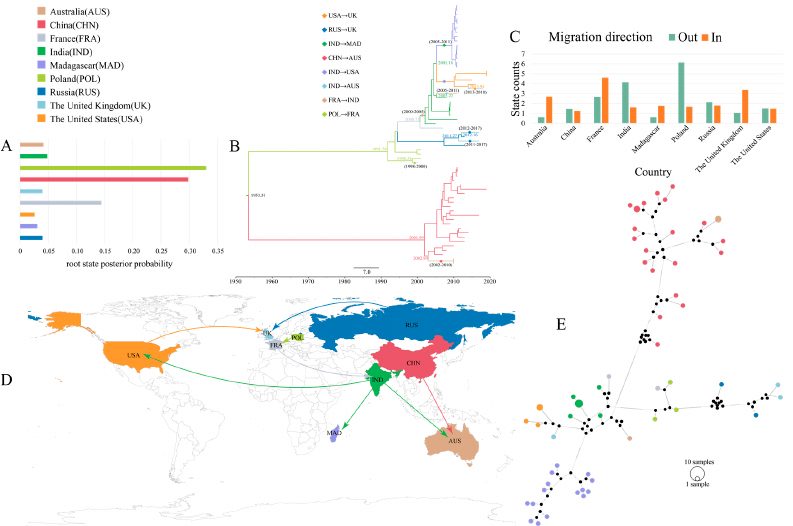
Figure 6. Phylogeographic analysis of CVB4. ( A ) Histogram of the posterior probabilities of the root states of the nine countries. Each country is assigned a different color (used to subsequently distinguish between different countries), with the horizontal and vertical coordinates being the posterior probabilities and different countries, respectively. ( B ) MCC tree of the VP1 region of 60 CVB4 sequences. The color of the branch represents the inferred location state, and solid diamonds indicate CVB4 spread between different countries, with the inferred years of spread marked nearby. ( C ) Histogram of the total number of inferred location state transitions for the nine countries. ( D ) Spatial diffusion pathways of CVB4 in different countries. Only migration pathways with BF values > 3 and indicators > 0.50 are shown. ( E ) Median-joining haplotype network of 60 CVB4